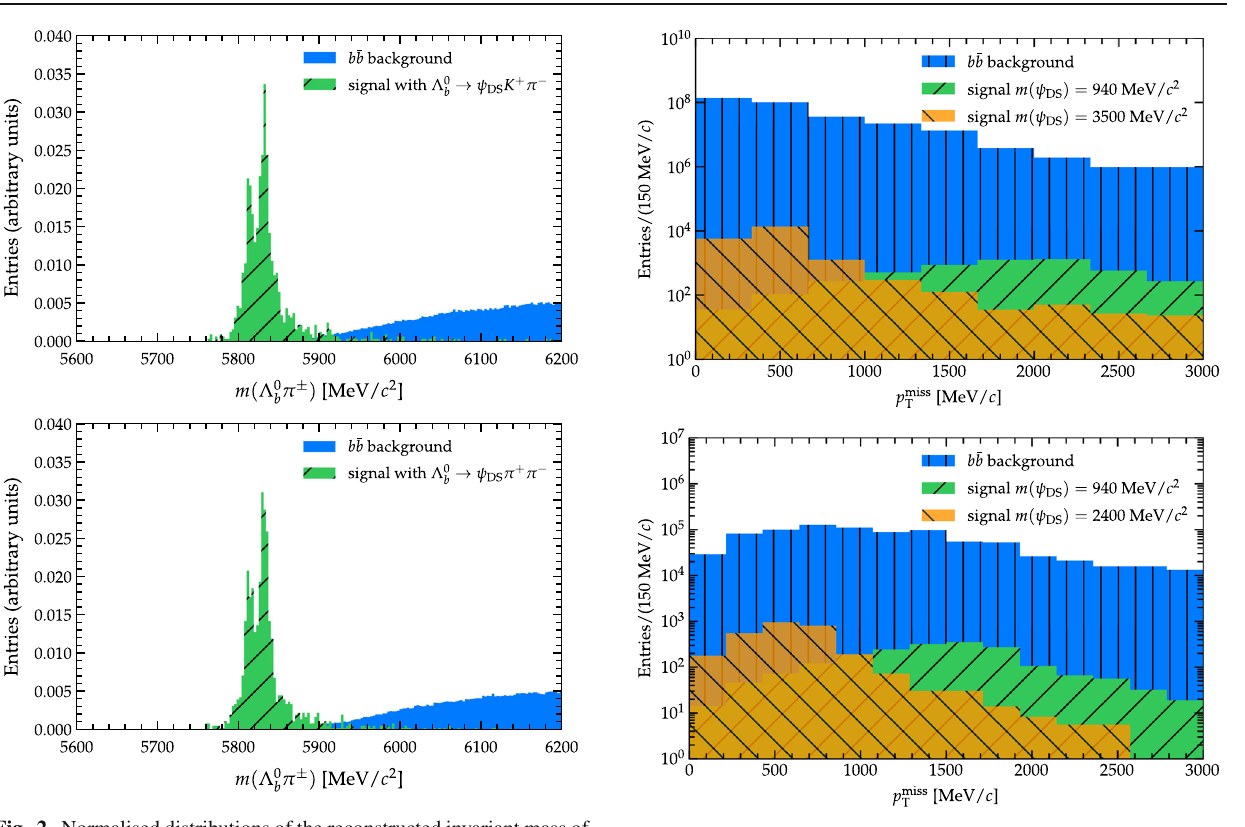
for B → ψ DS Λ and associated back- T